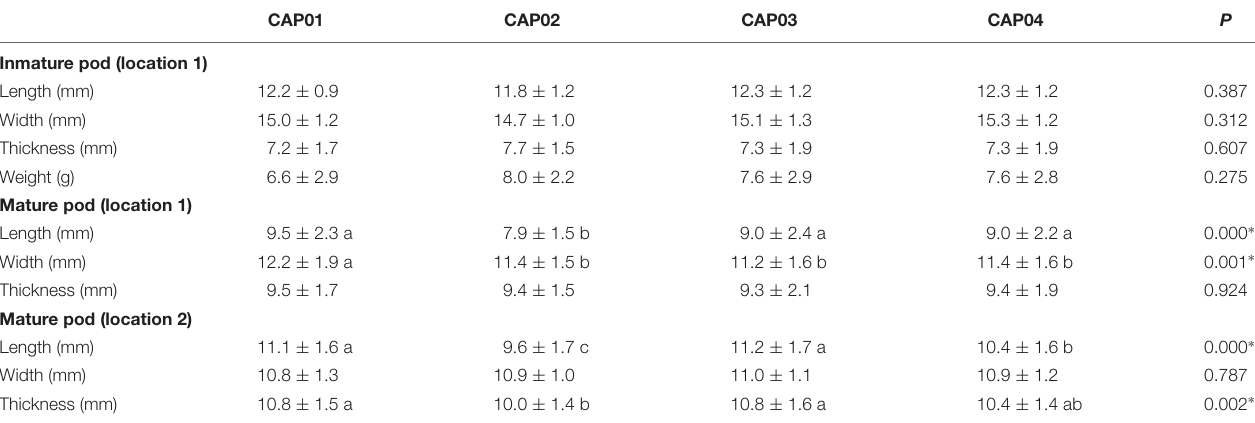
TABLE 1 | Mean values for selected pod-related parameters in four Caparrona de Monzón bean accessions (CAP01, CAP02, CAP03, and CAP04) grown in two locations (1: Montañana and 2: